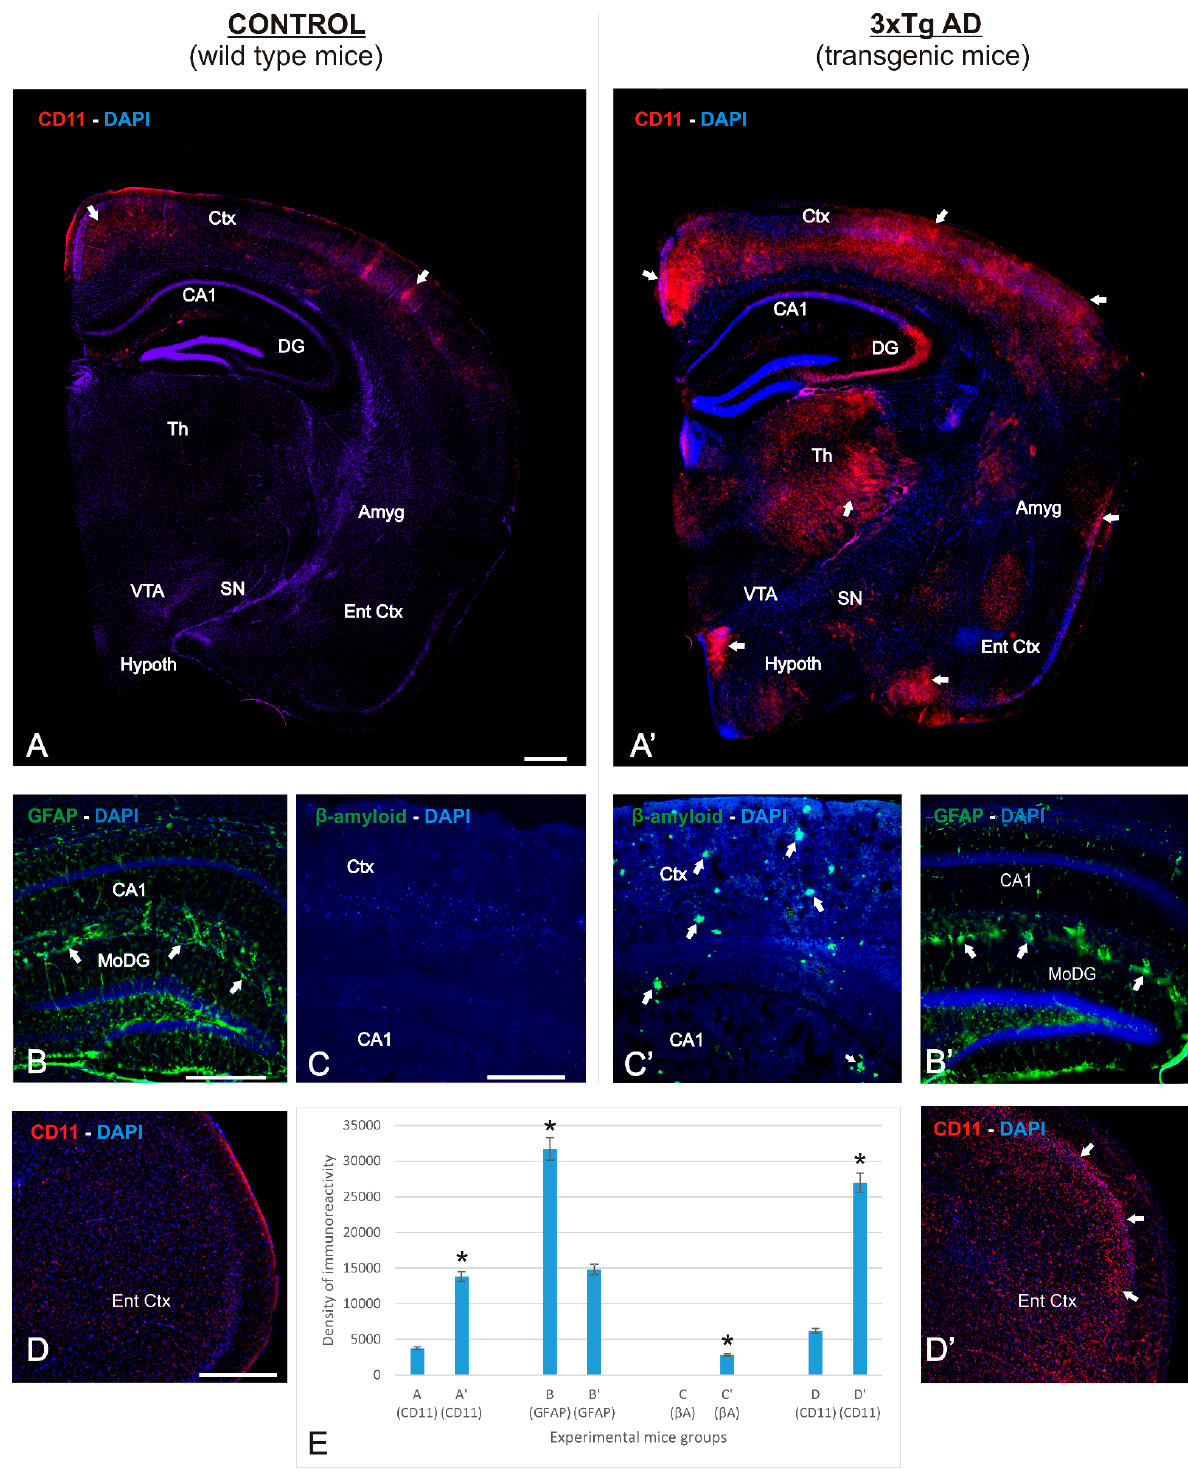
Figure 1. Immunolocalization of various markers in the APP/BIN1/COPS5 3xTg-AD mouse brain. Photomicrographs of different brain regions from wild-type ( n = 4) and APP/BIN1/COPS5 3xTg-AD ( n = 4) mice showing histopathological lesions identified via immunohistochemistry. (( A – D ), ( A’ – D’ )) Transverse sections of right half-brain ( A , A’ ), dentate gyrus ( B , B’ ), hippocampus ( C , C’ ), and entorhinal cortex brain levels of wild-type mice ( A – C ) and APP/BIN1/COPS5 3xTg-AD mice ( A’ – C’ ), showing strong differences in expression density. ( A , A’ ) Hemi-brain sections showing a basal level of the inflammatory marker CD11b in wild-type mice, contrasting with a highly-differentiated